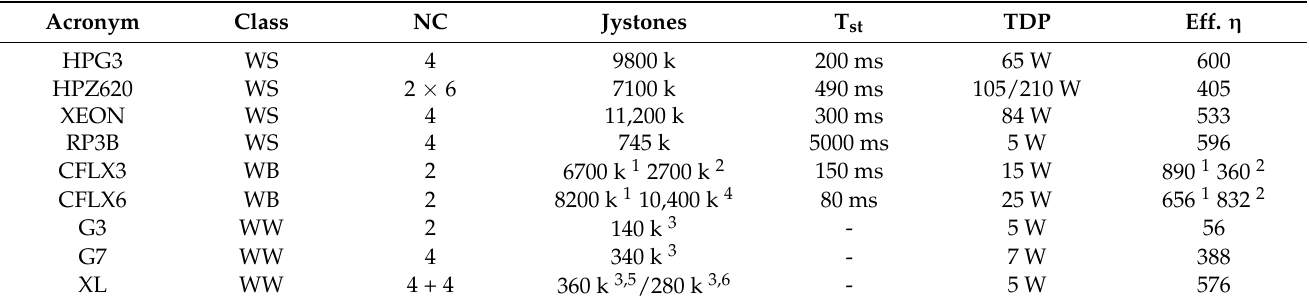
Table 3. Test hardware and software platforms ( 1 node.js, 2 Firefox 52, 3 Chrome 89, 4 Chrome